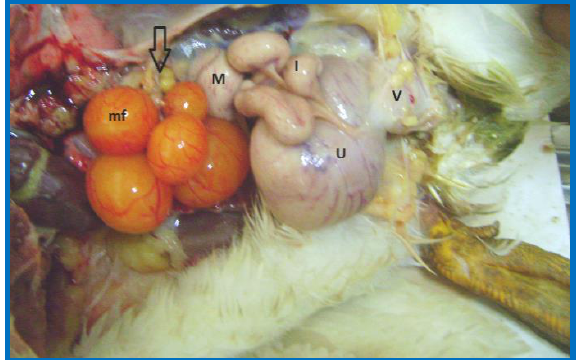
Figure, 4: Gross appearance of laying female body (24 weeks Mallard)duckshows: magnum (M), isthmus (I), uterus (U), vagina (V) mature follicles (mf) immature follicles (arrow).